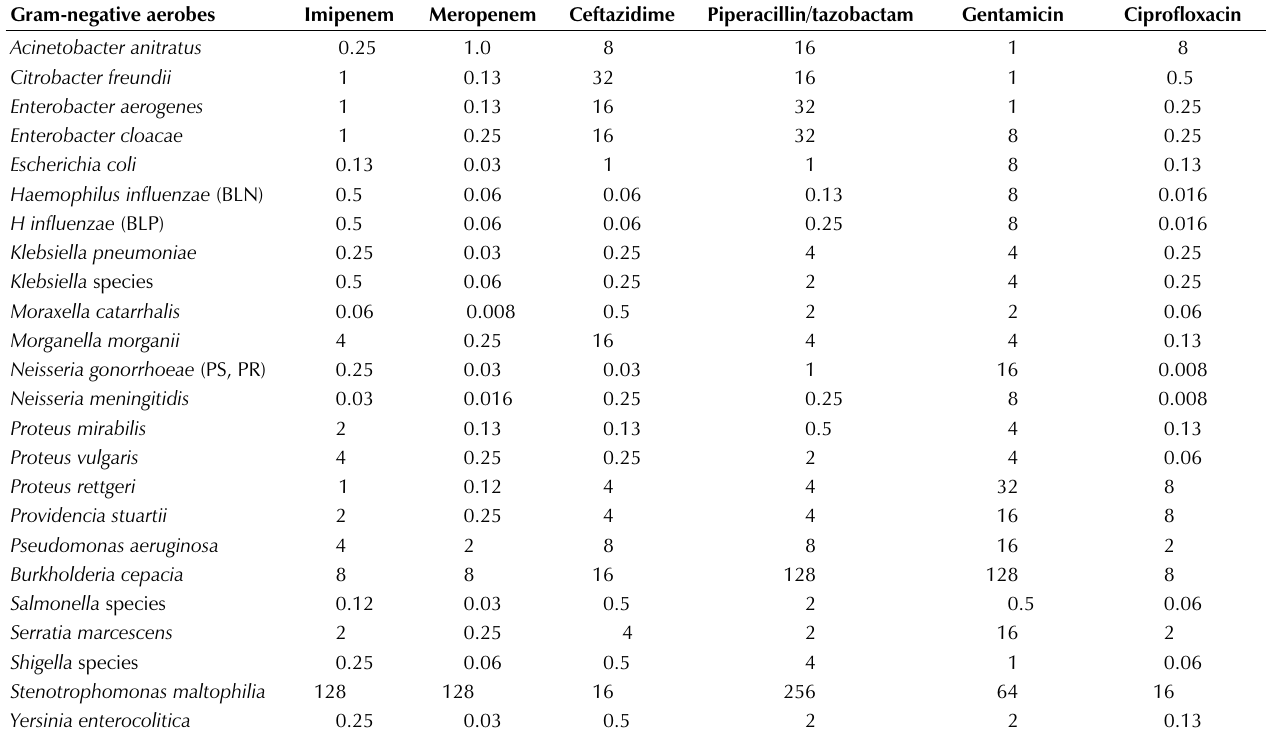
Antibacterial activity (minimum inhibitory concentration of 90% of isolates (cid:1) g/mL) of imipenem and meropenem in comparison with ceftazidime, piperacillin/tazobactam, gentamicin and ciprofloxacin against Gram-negative